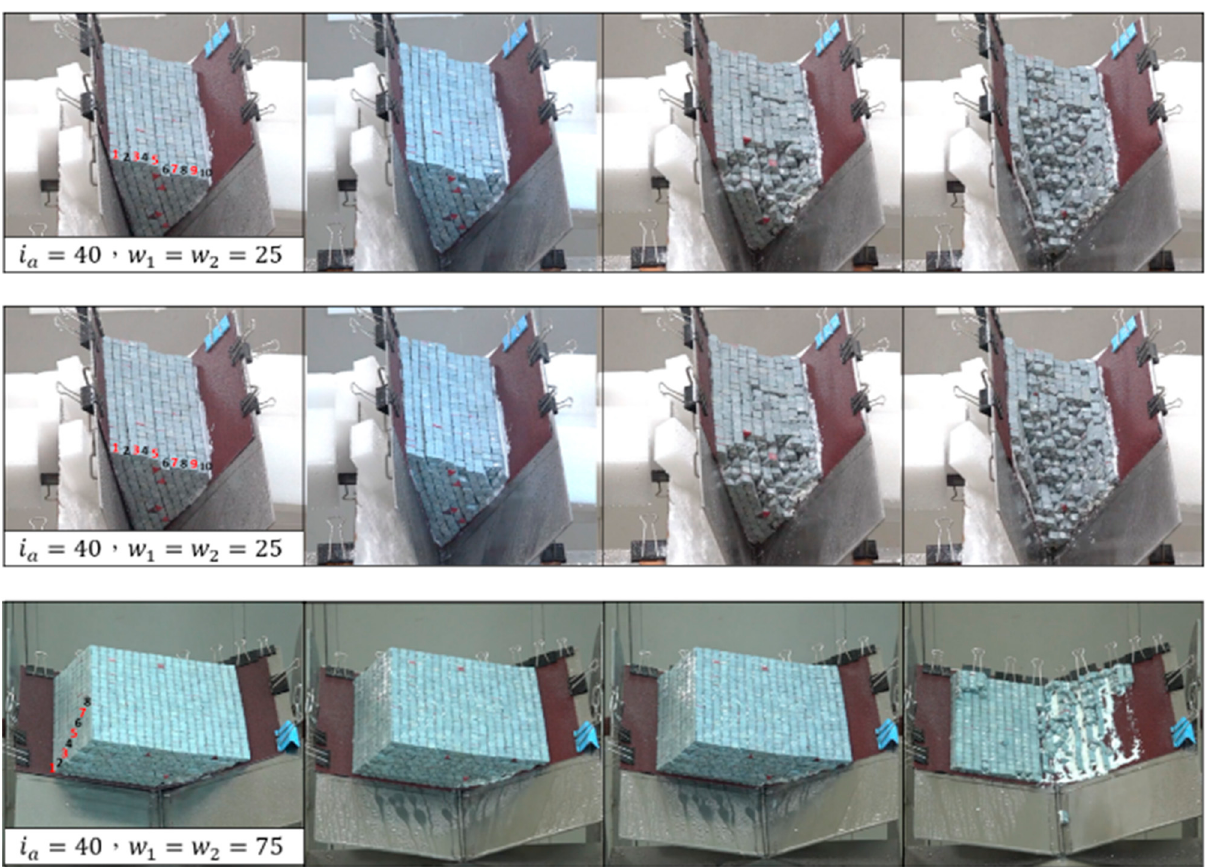
Figure 13. Comparison of tests with i a = 40° and different ω .